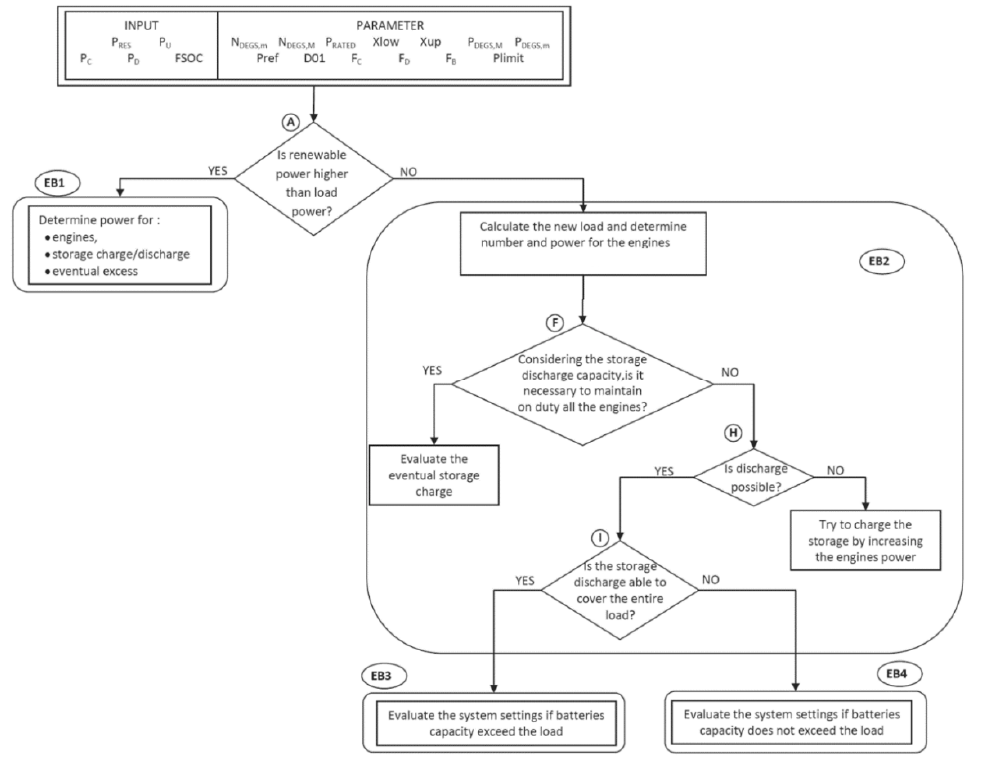
Figure 4. Control logic scheme flow chart.